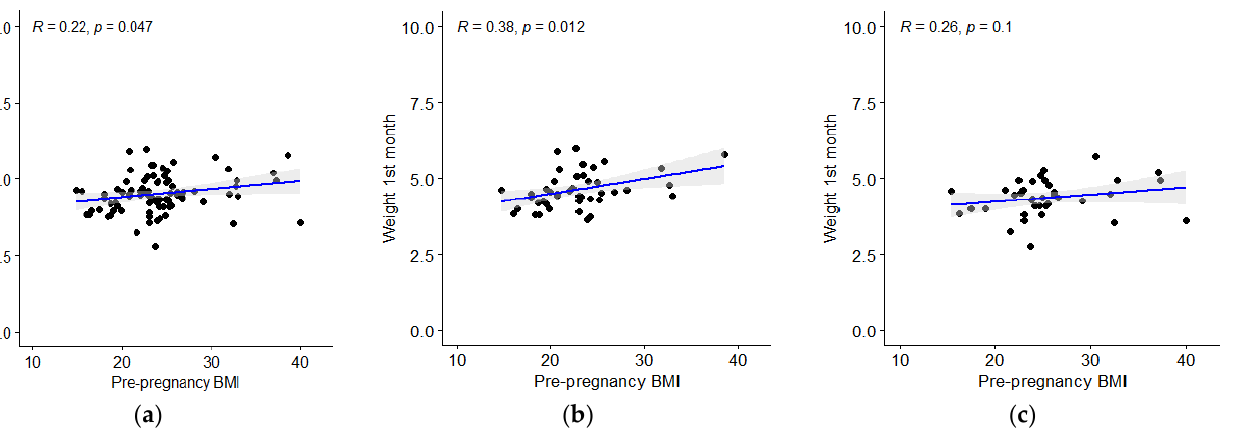
Figure 2. ( a ) Correlation between mother’s pBMI and child’s weight at first month of life; ( b ) corre- lation between mother's pBMI and weight of males at first month of life; ( c ) correlation between mother's pBMI and weight of females at first month of life.